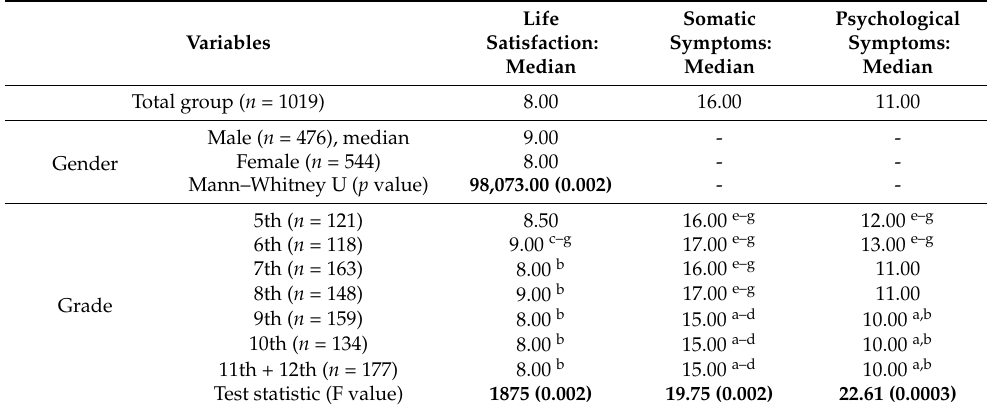
Table 3. Participants’ life satisfaction and somatic and psychological symptoms according to sociode- mographic